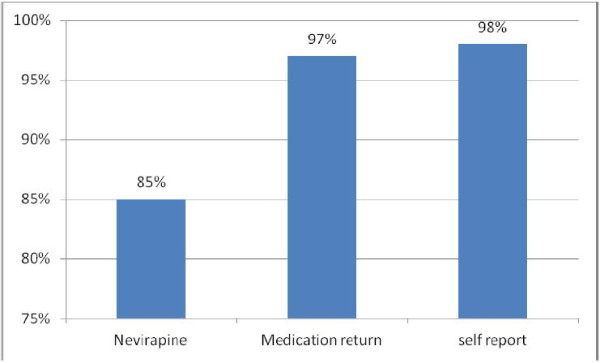
Proportion comparison of adherence.